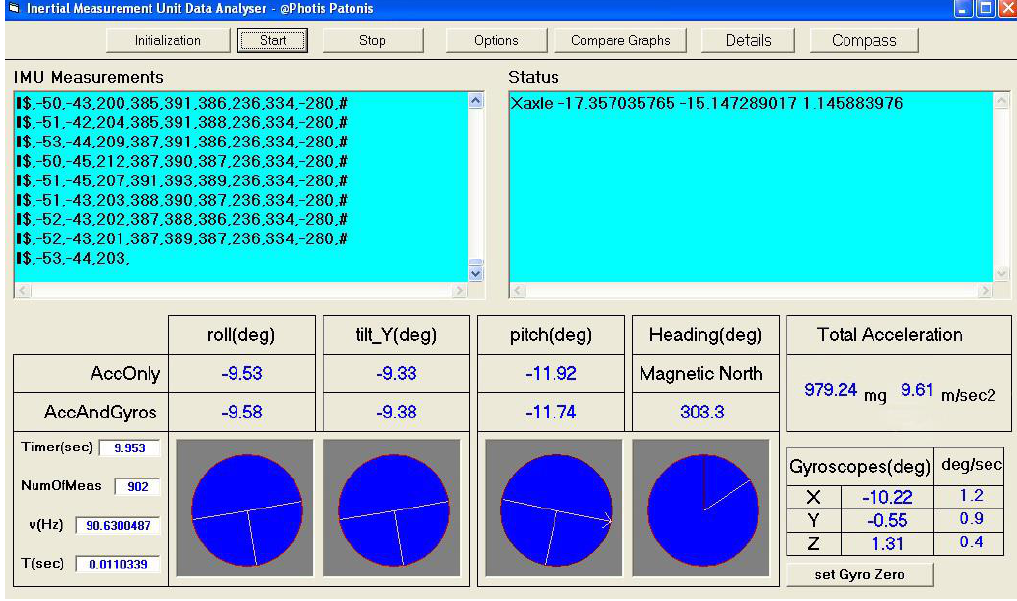
Figure 6. Inertial measurement unit data analyzer software utility.